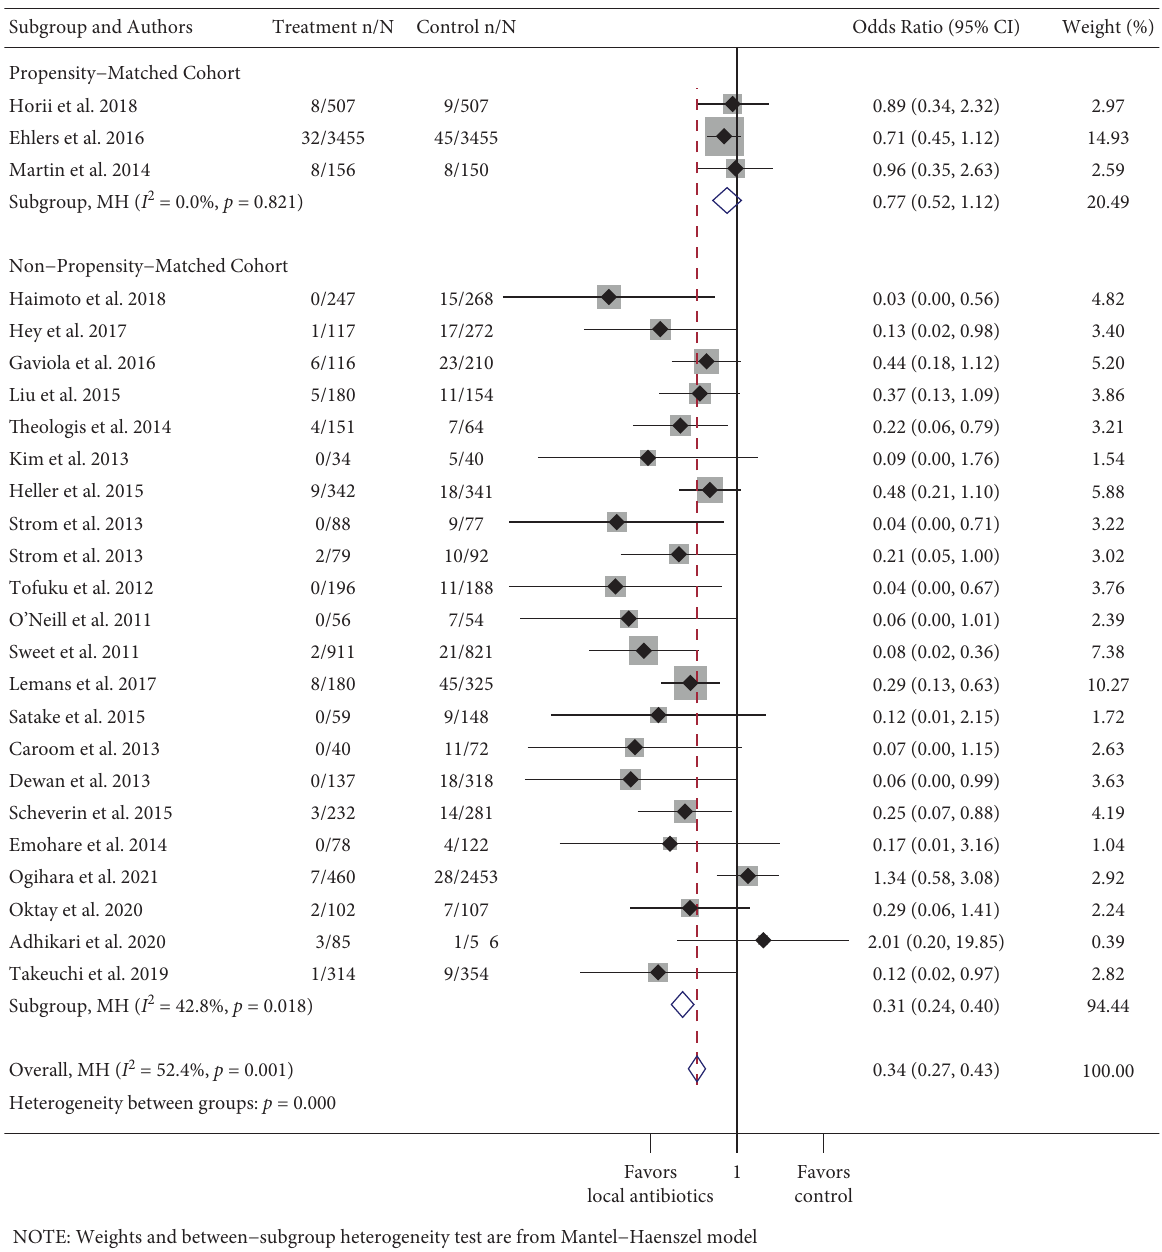
Figure 3: Forest plot of observational instrumented spinal fusion studies. Treatment n/N: number of infections in the treatment group/total number of patients in the treatment group. Control n/N: number of infections in the control group/total number of patients in the control